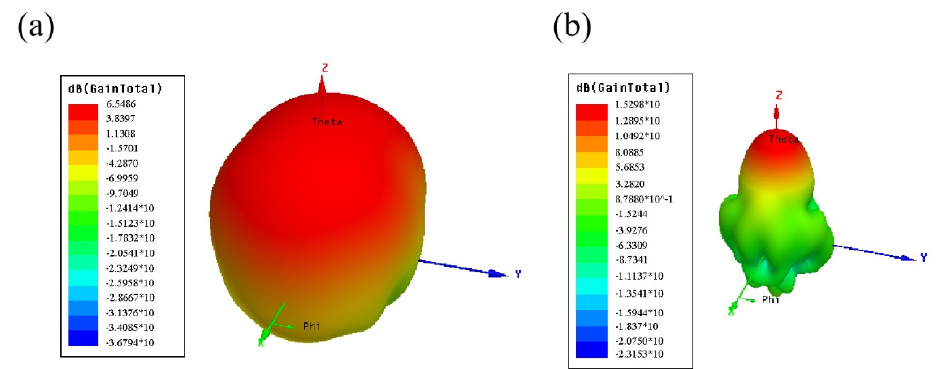
Figure 10. Comparison of the 3D polar coordinate gain of the microstrip antenna loaded with metamaterials and a reference antenna ( a ) Reference antenna; ( b ) Microstrip antenna loaded with metamaterials.